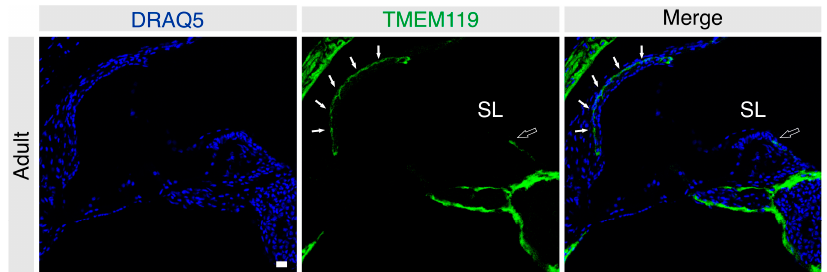
Figure 3. Frozen sections of the adult mouse cochlea labeled for TMEM119 (green). Nuclei were counterstained with DRAQ5-labeling (blue). TMEM119 protein expression was detected in the basal cells of the stria vascularis (solid white arrows) in the adult mouse cochlea. A specific signal was also observed in the mesenchymal dark cells of the supralimbal region (hollow arrows). The coch- lear bone shows a strong fl uorescence signal. Scale bar: 20 µm.